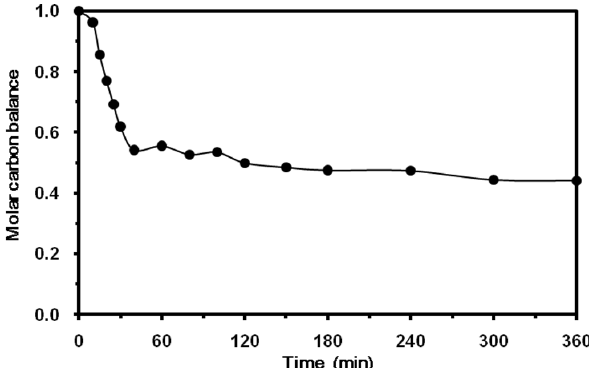
Fig. 5. The observed carbon balance (ratio of observed carbon ver- sus consumed carbon) as a function of time during the aqueous ox- idation of isoprene. Total experimental time was